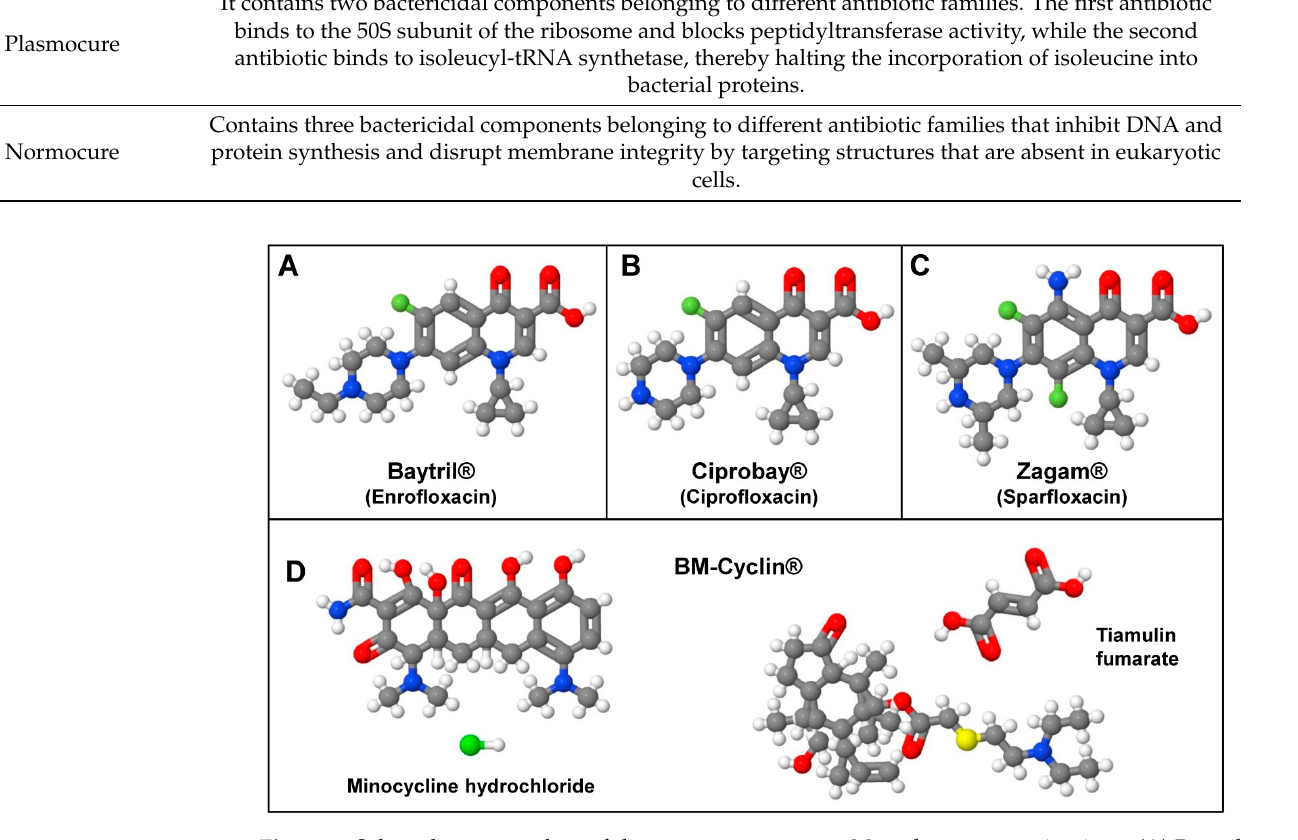
Figure 3. Selected compounds useful to remove or prevent Mycoplasma contaminations. ( A )